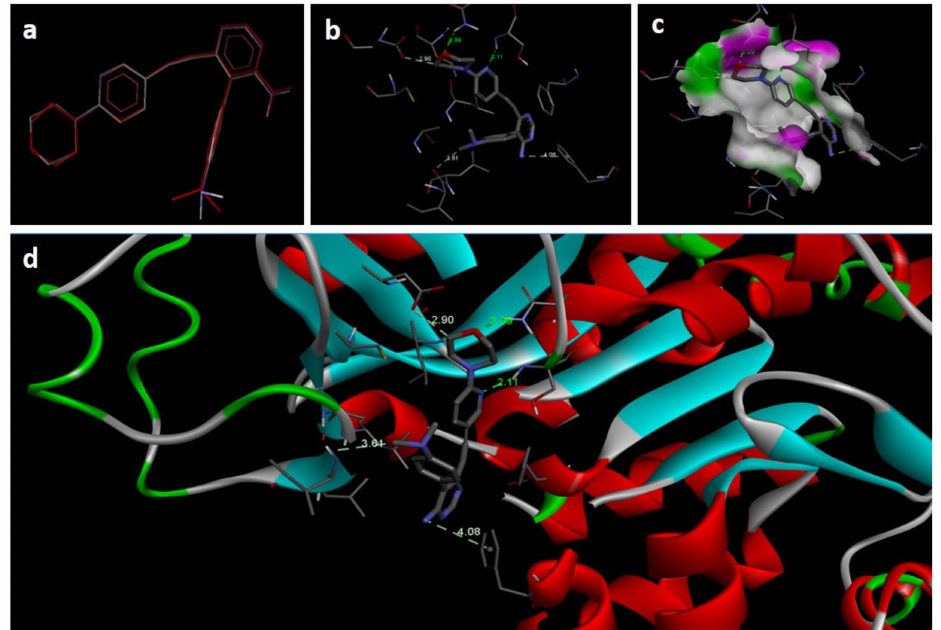
Figure 5. Docking images of co-crystallized ligand on 2I6B: ( a ) validation of docking method; ( b ) H-bonds between ligand (89I) and protein residues; ( c , d ) 3D representation of interactions in binding